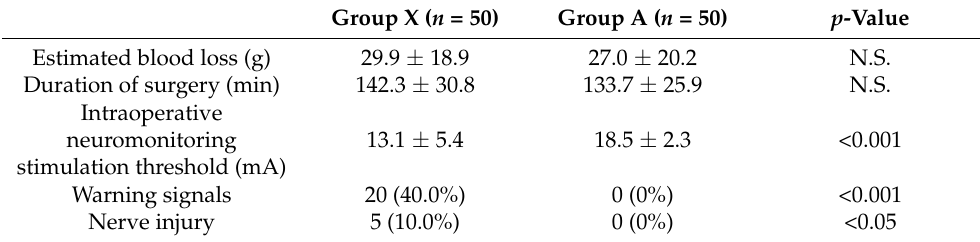
Table 2. Perioperative and postoperative findings of the patients in each